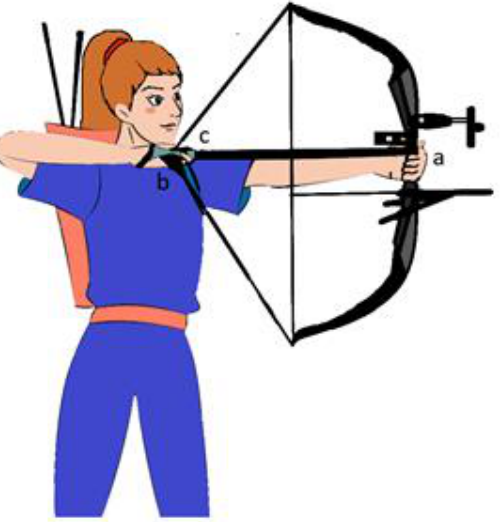
Figure 1. Parts of the arch compound and shooting technique: ( a ) riser, ( b ) rope and ( c ) arrow. The hooking of the back of the arrow ( c ) to the rope ( b ) it is done by placing first the third finger and fourth finger of the right hand and then the second finger of the same hand. The rope is placed between the second and third phalanxes of the fingers who are found to be subjected to vibrating and frictional stresses due to contact with the rope. The back of the arrow should be hooked to the string between the third finger and the second finger, while the fifth finger and the first remain detached and less prone to mechanical stress. The left hand is the hand of the bow or hand on the riser ( a ) and must be positioned so that the knuckles come to draw an angle of about 45 degrees on the vertical to press the grip against the thenar eminence, why it is the eminence that is the most affected by the pressure rather than the fingers of the hand.